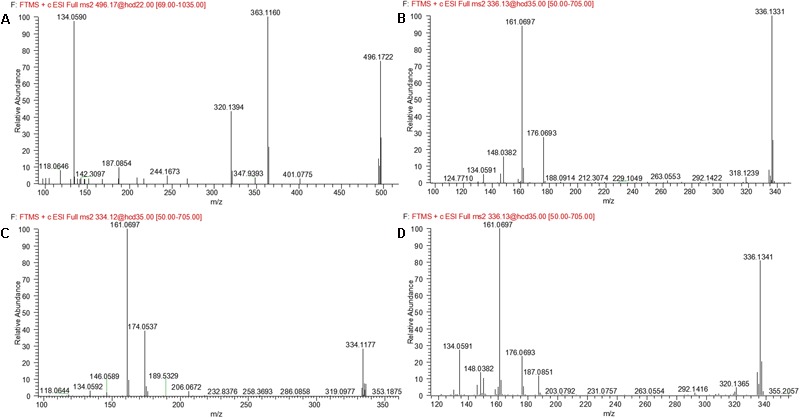
MS2 spectra of M10 (A), M11 (B), M12 (C), and M13 (D).